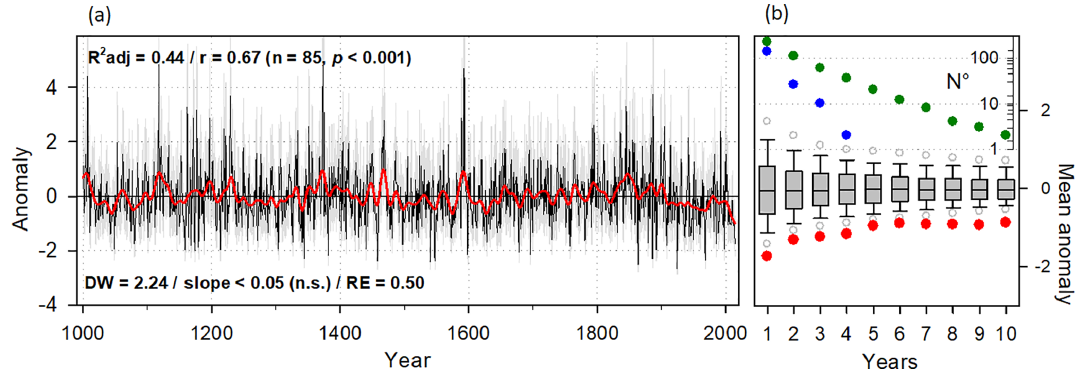
Figure 6. Left panel: the tree-ring reconstruction of winter–early summer (June–December) normalized precipitation anomalies from central Chile plotted annually from AD1000 to 2014. The red line indicates a 25-year Gaussian filter to emphasize the multi-decadal variations. The shaded area denotes the 1 ± root-mean-square error from the residual fit to the instrumental series. Right panel bottom: box-and-whisker plots (grey and black) indicating the median and the 5th, 10th, 25th, 75th, 90th and 95th percentiles of the running mean (RM) anomalies of the reconstruction from 1 to 10 adjacent years. The red dots indicate the lowest mean values of RM from the 2010–2014 reconstruction period for the case of RM<5 (years), and for the case of RM>5 (years) the corresponding RM starts from 2014 back. Right panel top: number (no.) of droughts (log scale) in the reconstruction with a threshold of − 0.15 (green dots) and − 0.9 (blue dots), in relation to the years’